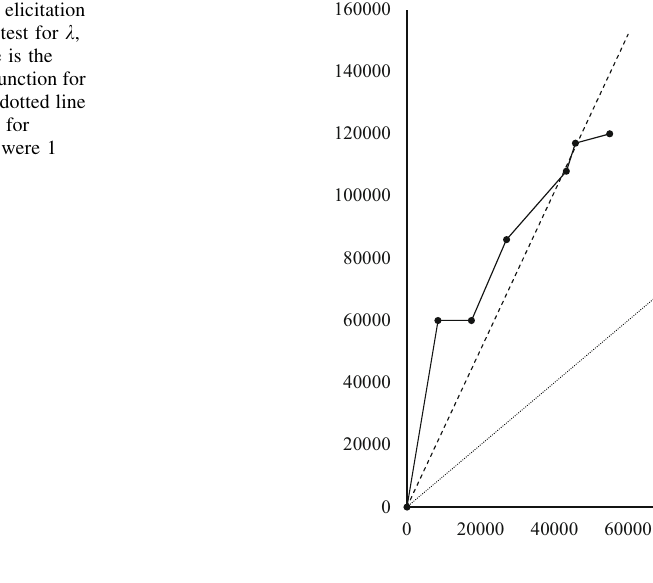
Fig. 6 Loss aversion elicitation according to the T/K test for k , where the dashed line is the linearly interpolated function for loss aversion and the dotted line is a function of y ¼ x for reference, that is if k